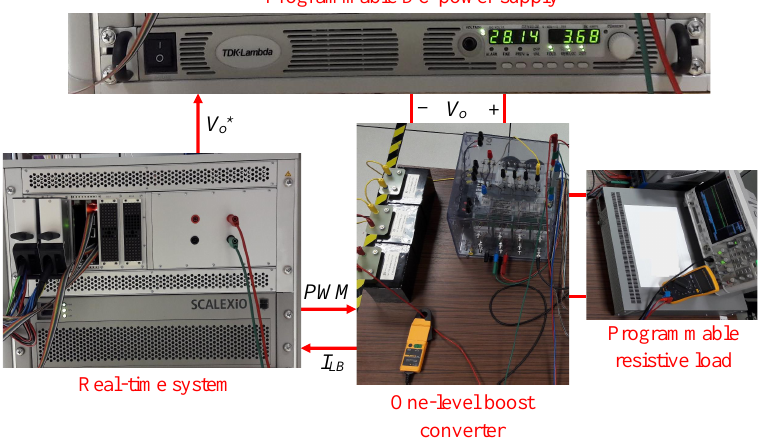
Figure 6. Scheme of P–H–i–L system: Real–time system is connected to the programmable DC power supply, and the one–level boost converter is connected to the programmable resistive load.